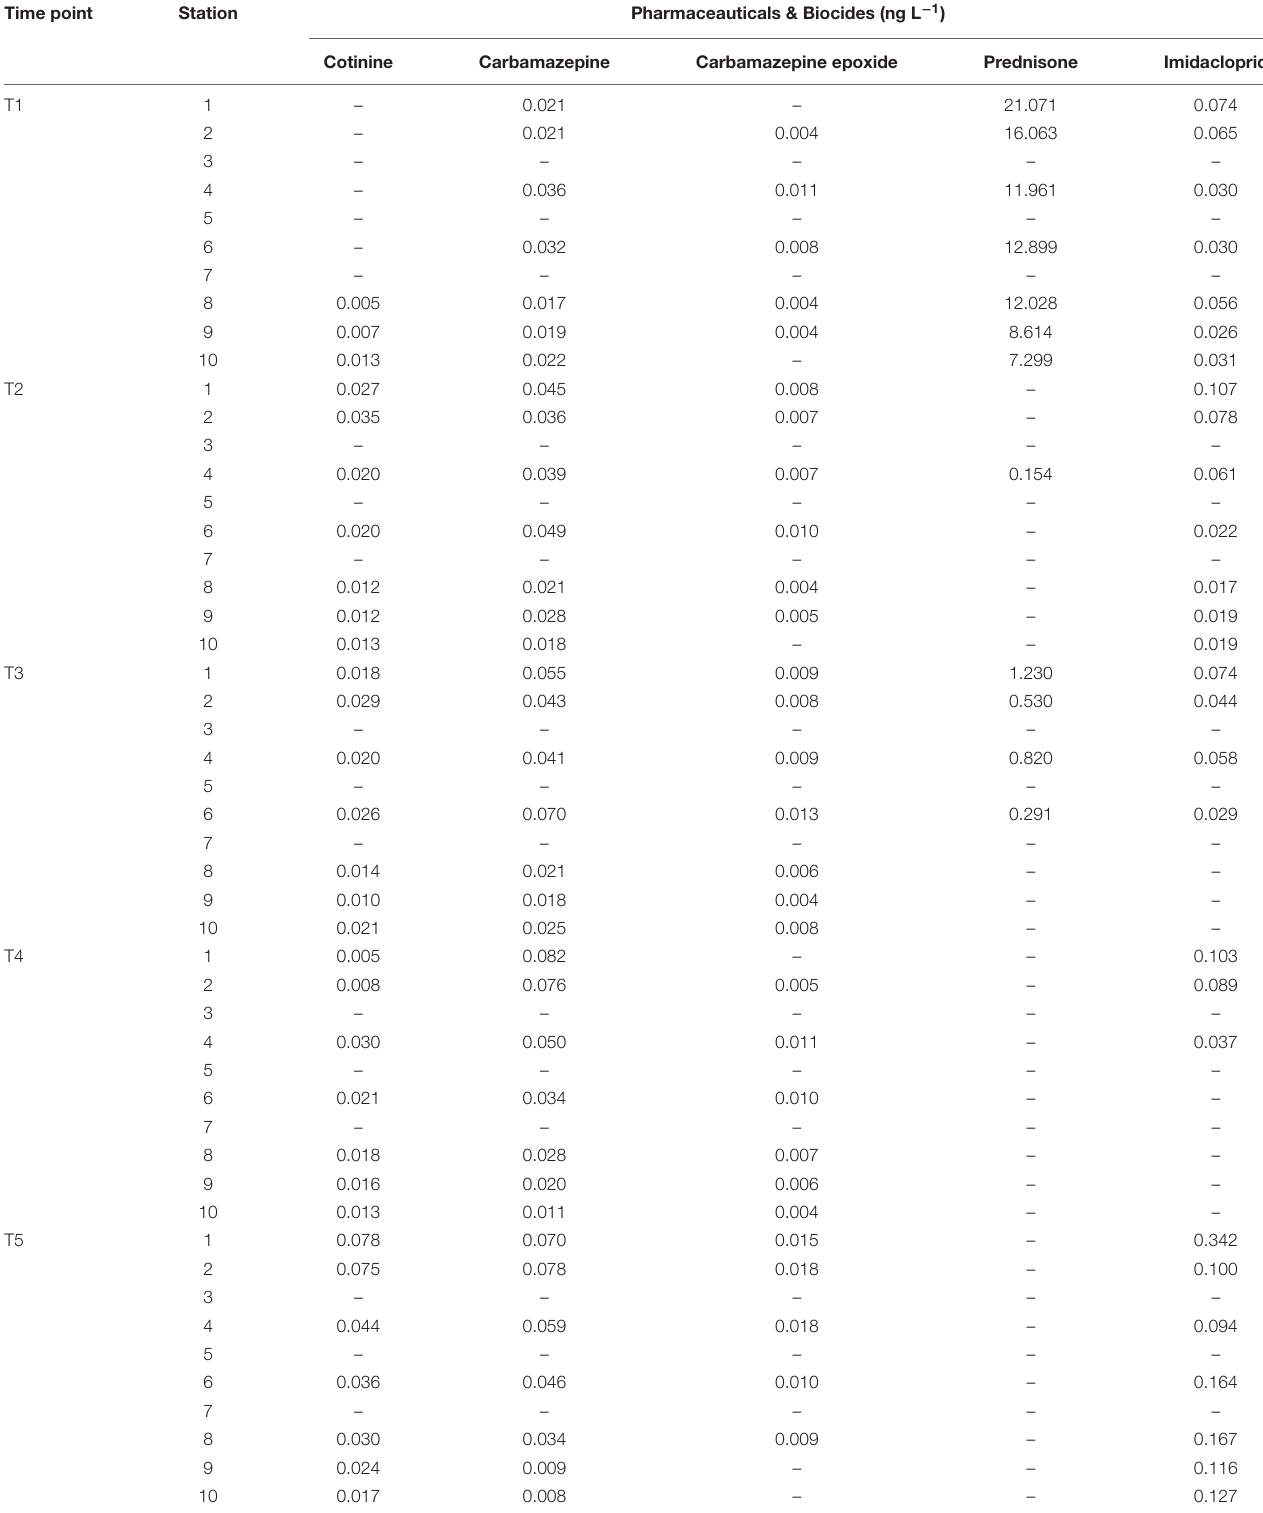
TABLE 2 | Additional abiotic factors including the pharmaceuticals and biocide data collected at each time point at the respective time point and station. Time